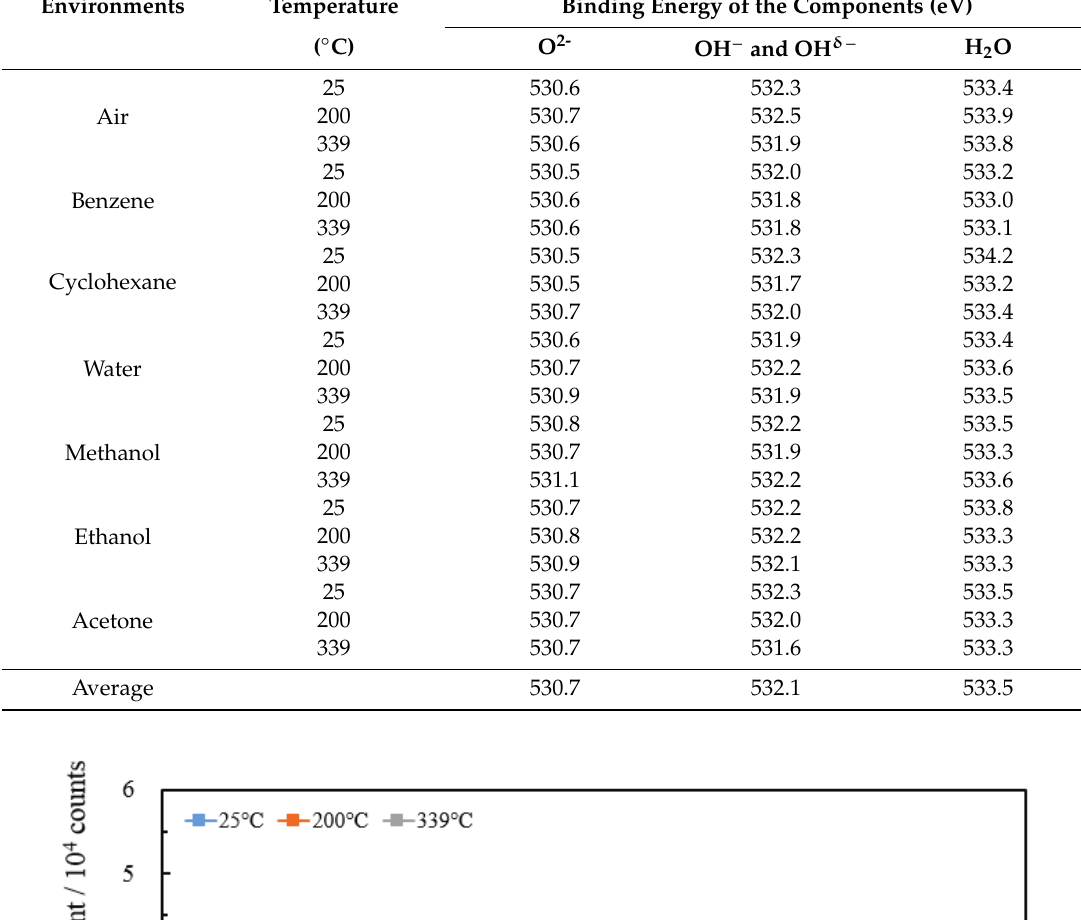
Table 3. Temperature dependence of binding energies of three components of O 2- , OH − and OH δ − , and H 2 O in the O 1 s spectrum for iron surfaces scratched in di ff erent environments.